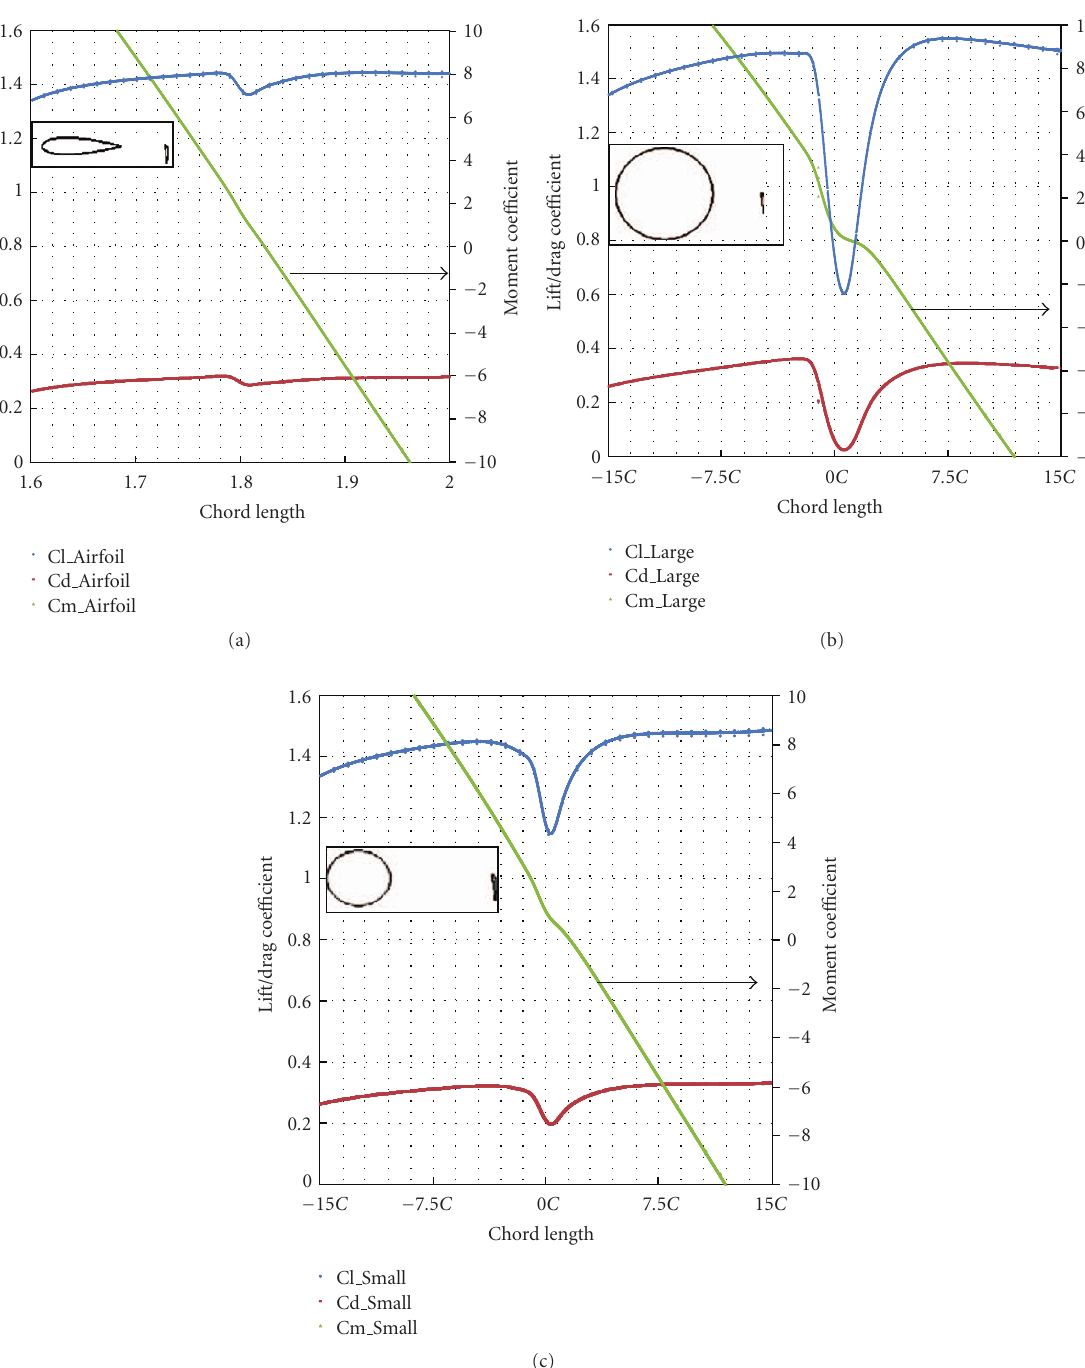
Figure 8: Time history of aerodynamic coe ff . and the moment around tower